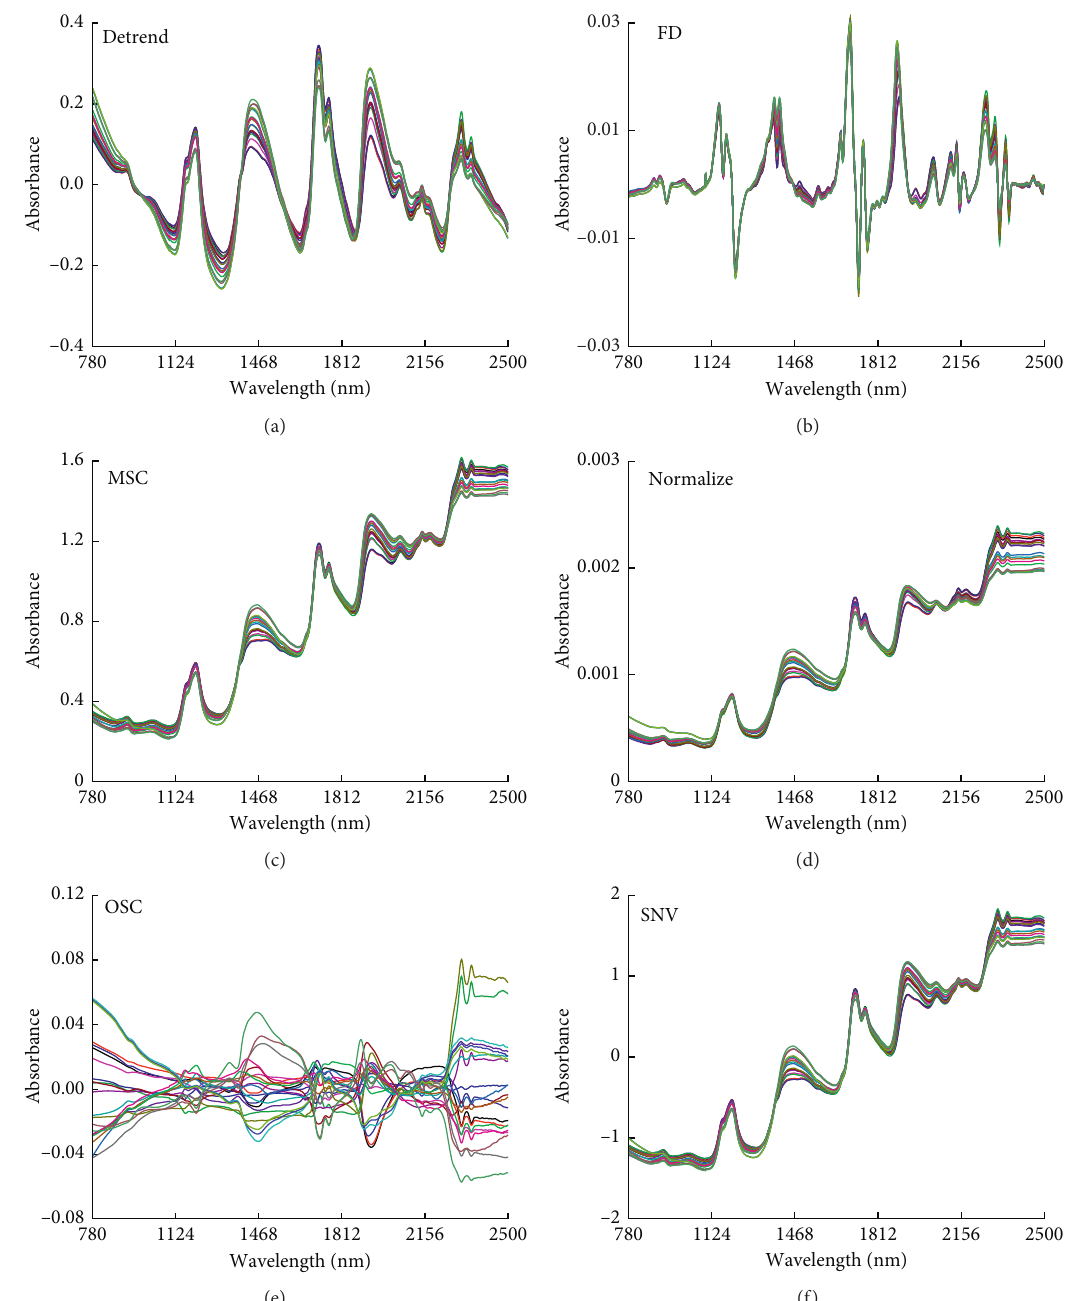
Figure 2: The near-infrared diffuse reflectance spectra of walnut kernel with different pretreatment